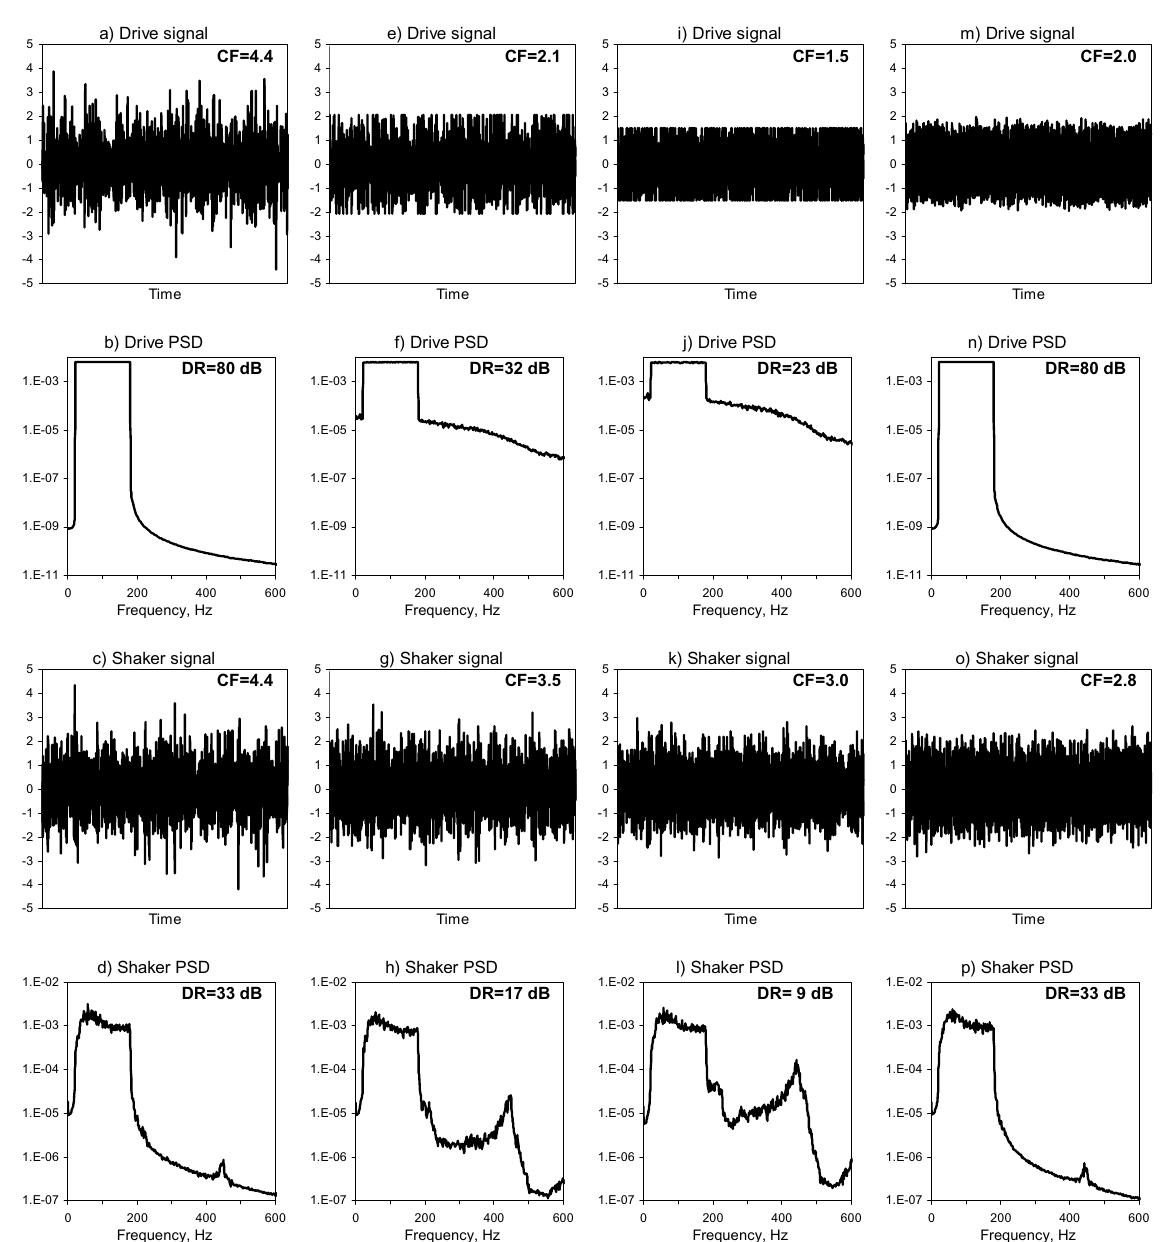
Fig. 2. Experimental results for no clipping (a,b,c,d), 2 σ clipping (e,f,g,h), 1.2 σ clipping (i,j,k,l), and non-Gaussian phase selection method (m,n,o,p). With clipping added the crest factor values are expected to change. First, the 3 σ clipping (that is a popular test specification) was tried but no noticeable change was observed in the acceleration output crest factor compared to the above value with no clipping. This is not a surprise for those who have ever checked the actual crest factor of